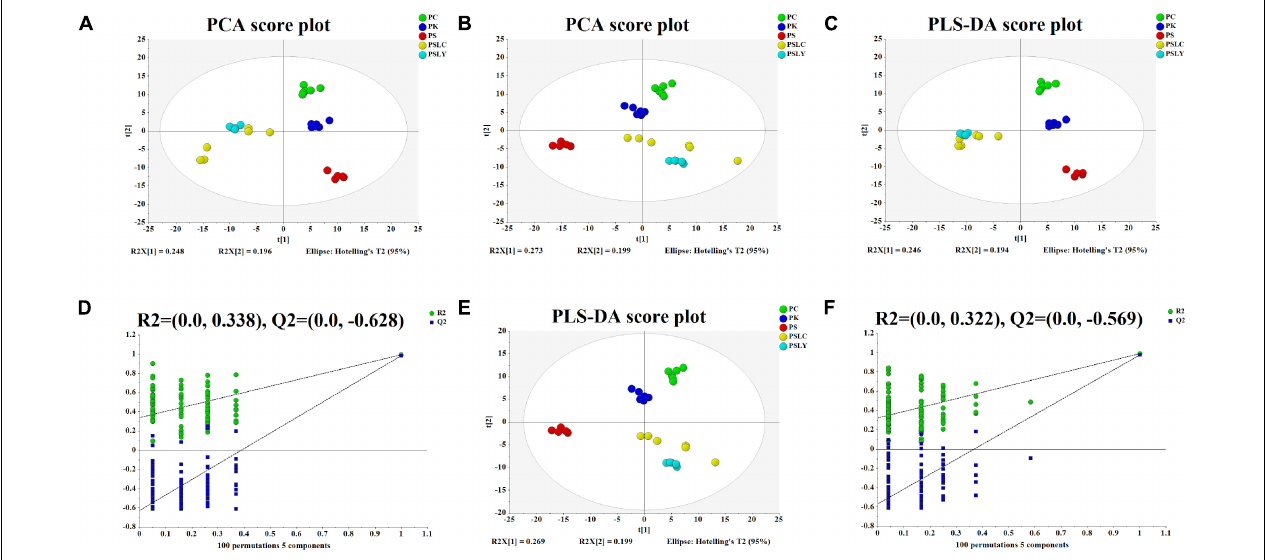
FIGURE 2 | PCA and PLS-DA score plots and the PLS-DA permutation test chart. (A) Positive ion mode of PCA score plot (R 2 X = 0.735, Q 2 = 0.572). (B) Negative ion mode of PCA score plot (R 2 X = 0.736, Q 2 = 0.529). (C) Positive ion mode of PLS-DA score plot (R 2 X = 0.734, R 2 Y = 0.988, Q 2 = 0.971). (D) Positive ion mode of PLS-DA permutation test. (E) Negative ion mode of PLS-DA score plot (R 2 X = 0.734, R 2 Y = 0.983, Q 2 = 0.956). (F) Negative ion mode of PLS-DA permutation